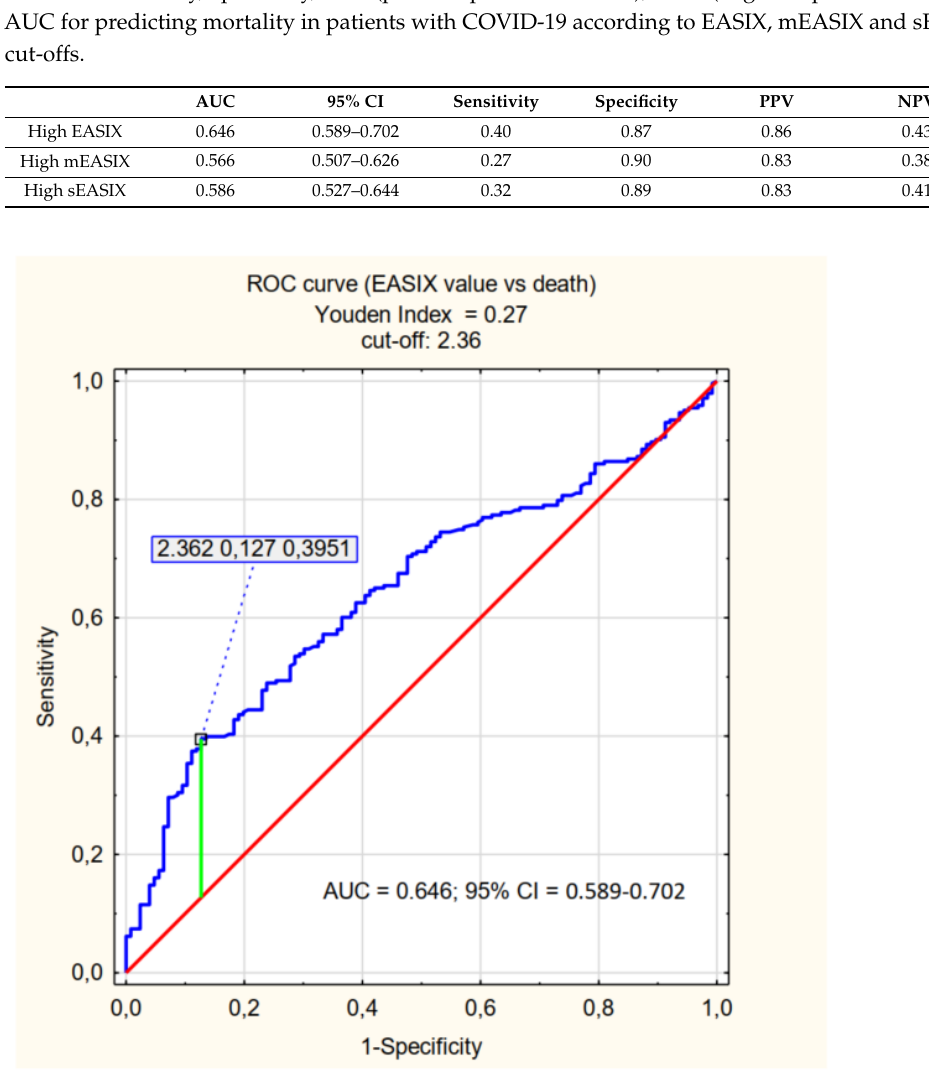
Figure 2. ROC curve (effect of mEASIX value on death) = mEASIX cut-off.